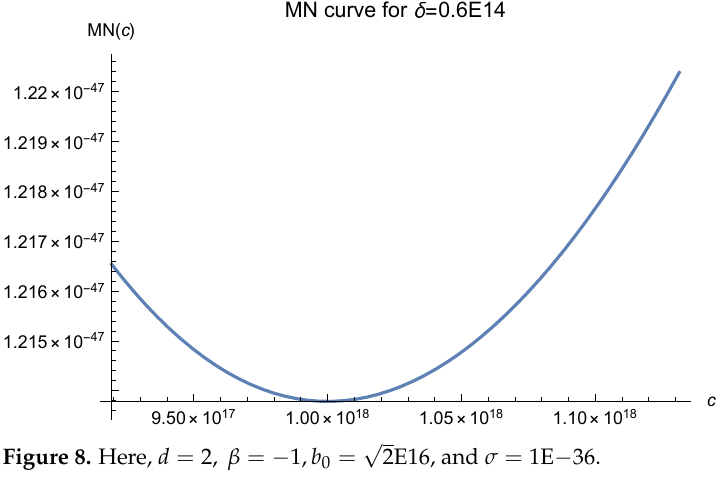
Figure 8. Here, d = 2, β = − 1, b 0 =